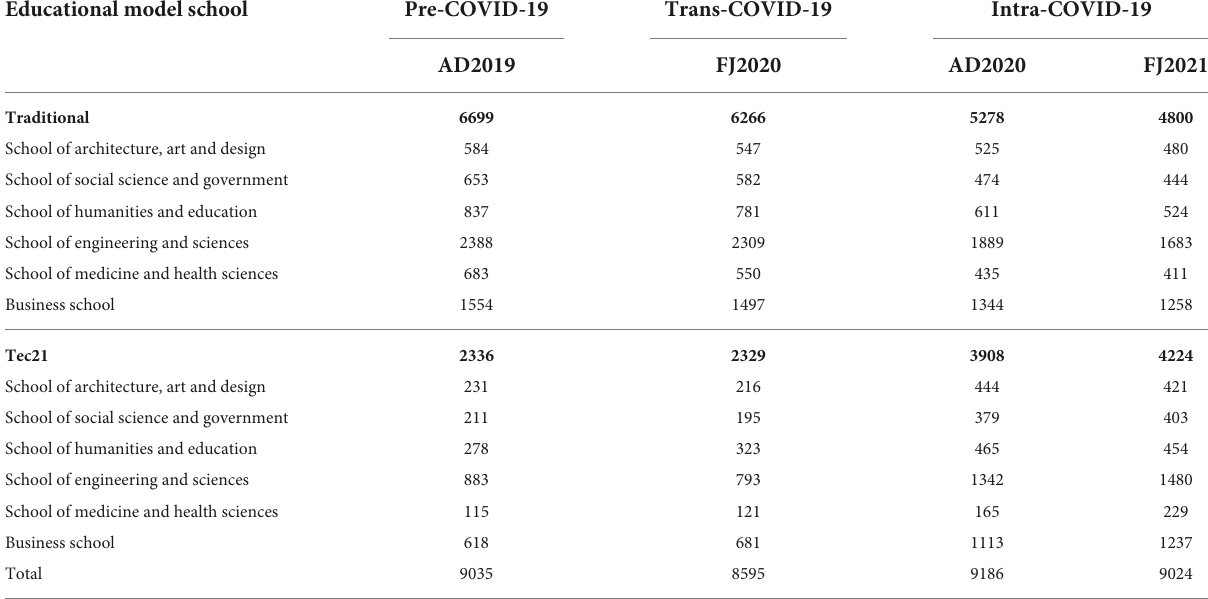
TABLE 1 Summary of participants in each educational model and school in the pre-, trans, and intra-COVID-19